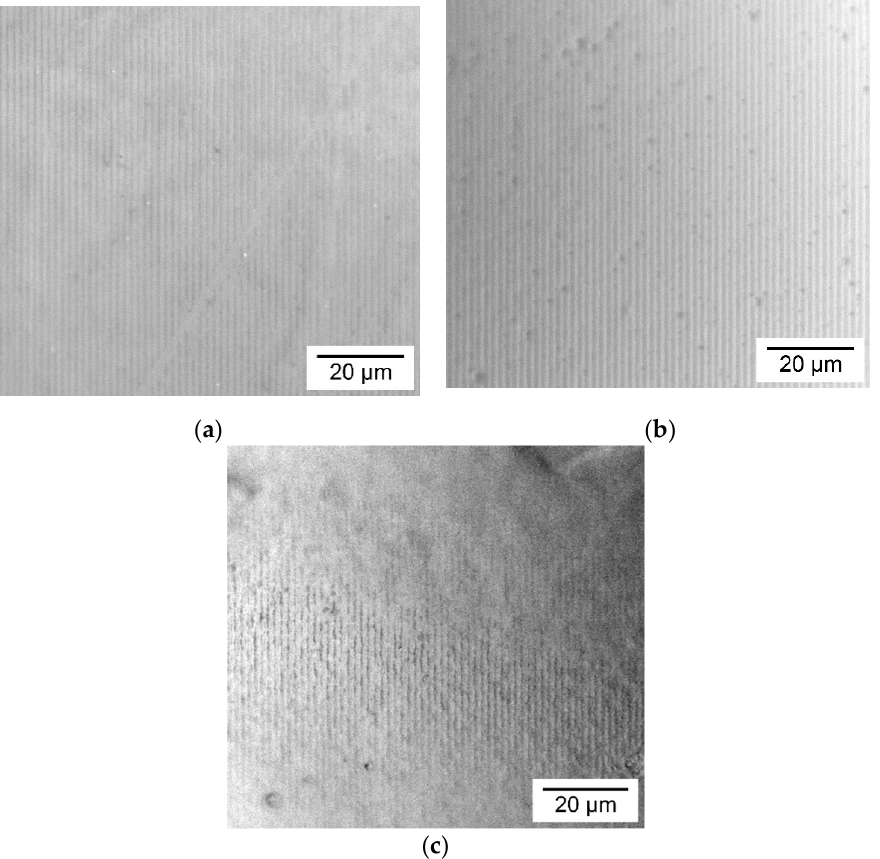
Figure 3. Reflected microphotographs of the holographic markers on the coatings surface made from ( a ) potato starch ( b ) gelatin and ( c ) agar.